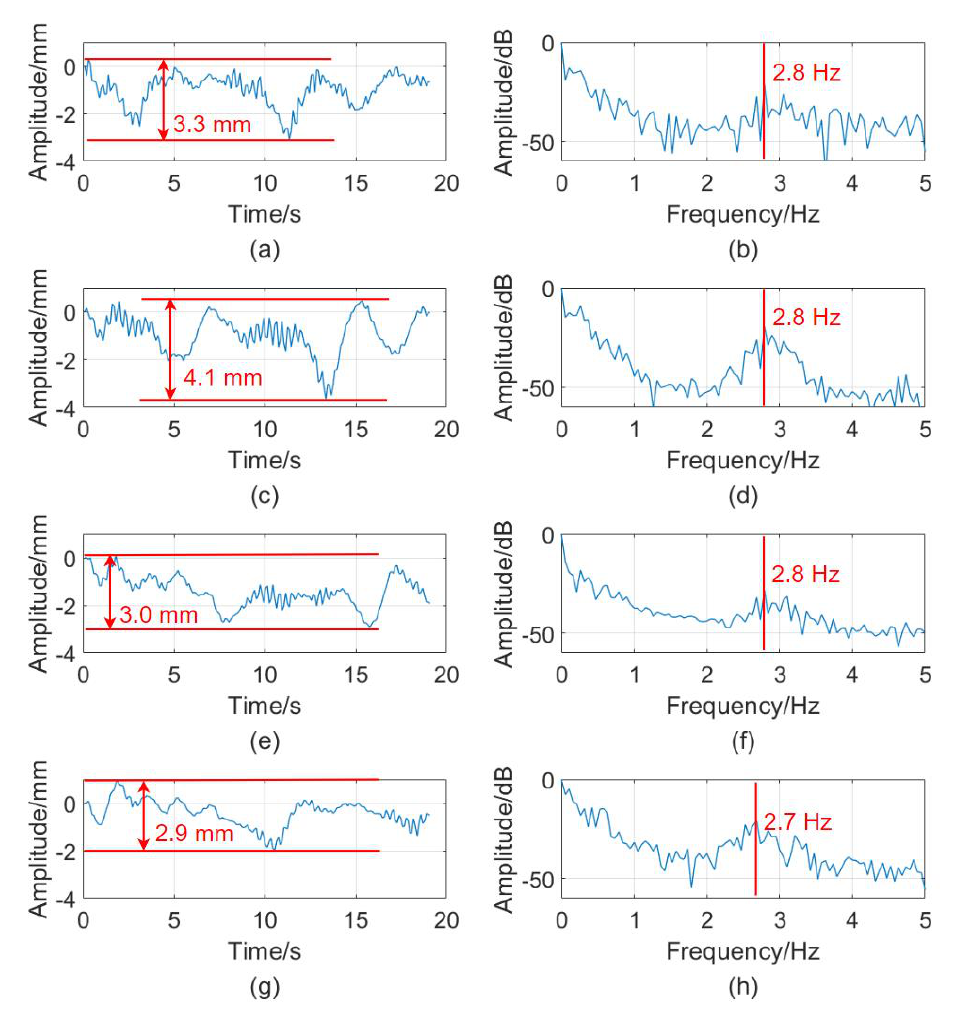
Figure 16. Measurement results of a large number of vehicles passing by at 11:10 on 27 August 2021. ( a , b ) show the deformation curve and spectrum of point 1. ( c , d ) show the deformation curve and spectrum of point 2. ( e , f ) show the deformation curve and spectrum of point 3. ( g , h ) show the deformation curve and spectrum of point